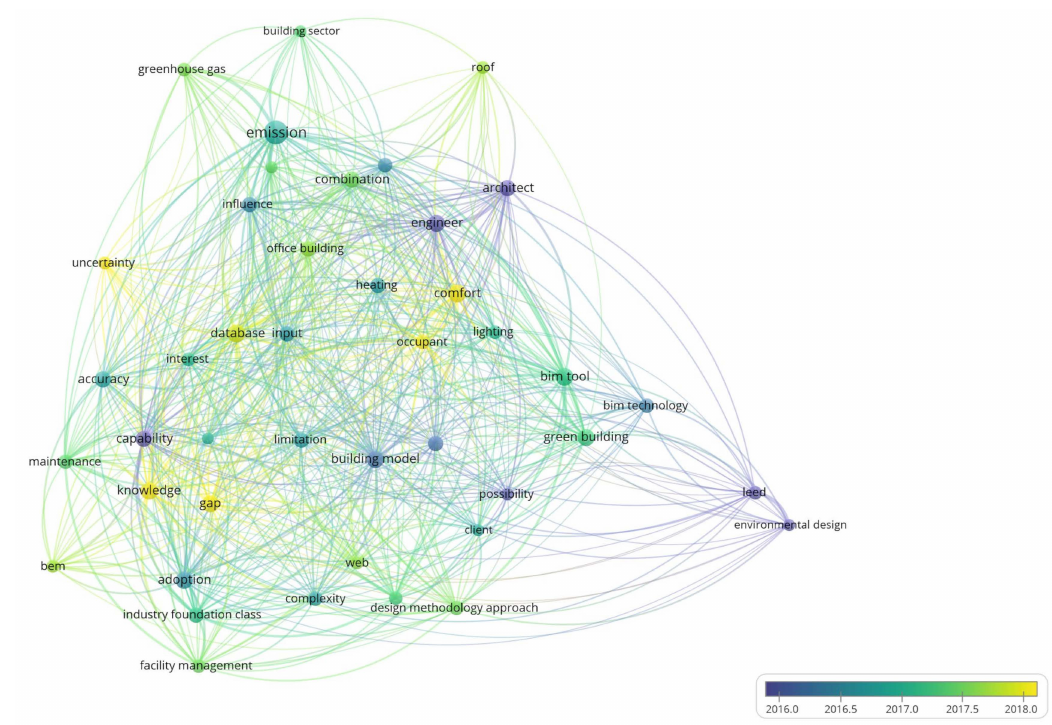
Figure 4. The moderately used keywords in BIM and building energy efficiency.